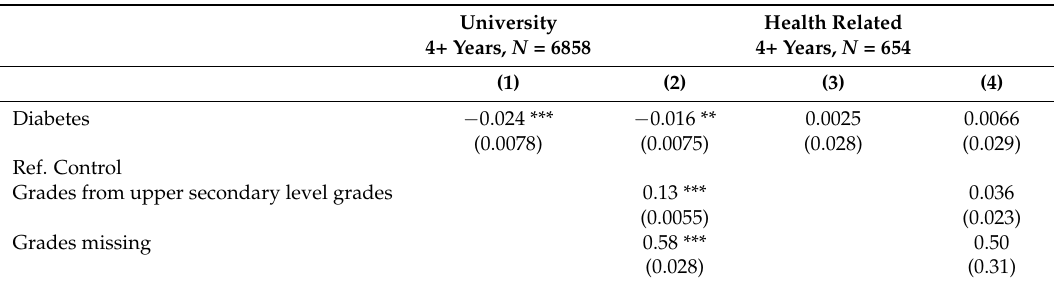
Table 9. Average marginal effects of men’s probability of having a university education longer than four years and the probability of having a health-related university education longer than four years for those with a university education longer than four